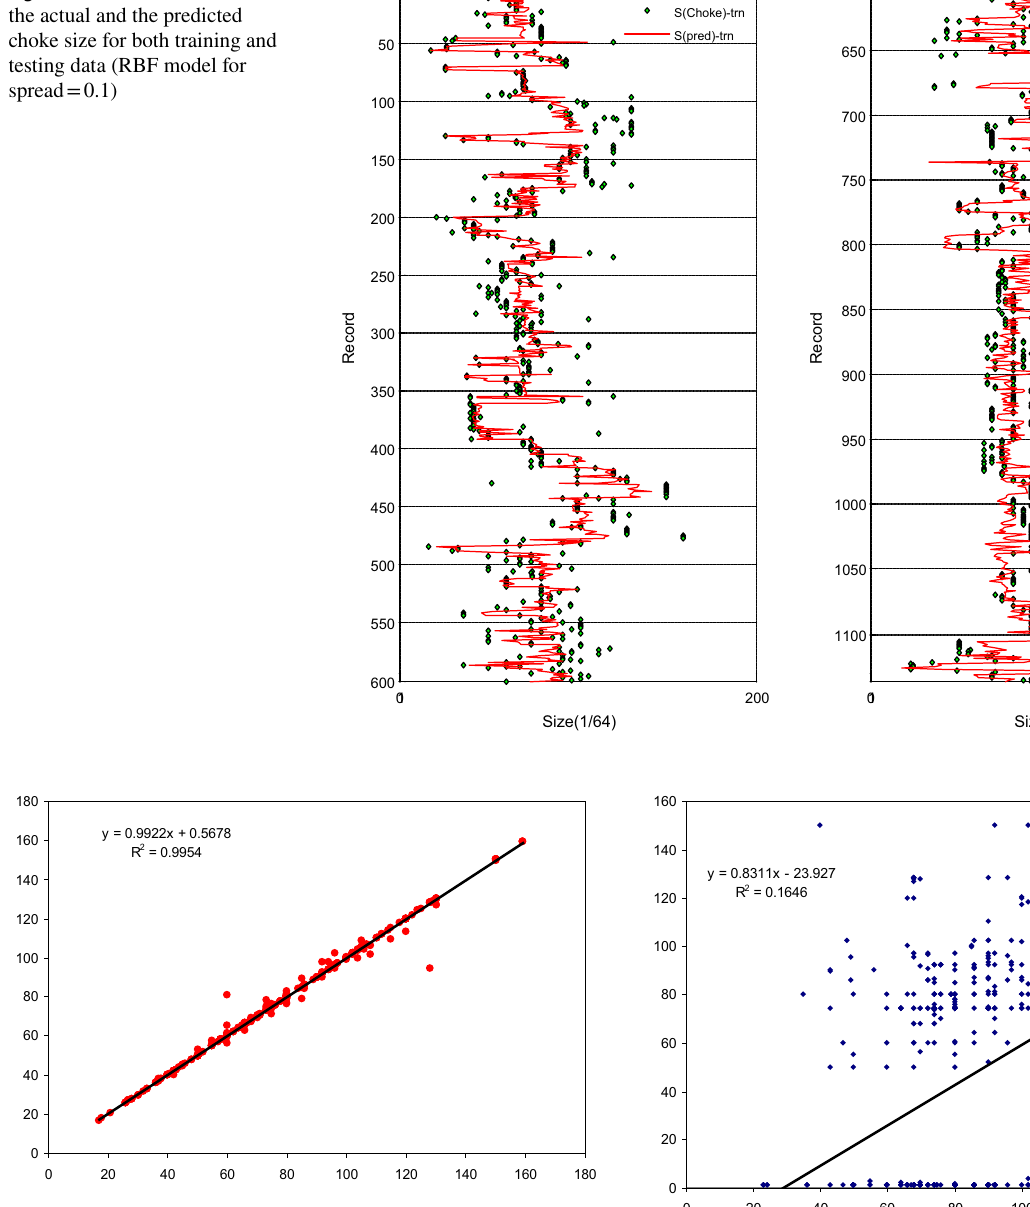
Fig. 16 Correlation between the actual and the predicted choke size for both training and testing data (RBF model for spread = 0.1)